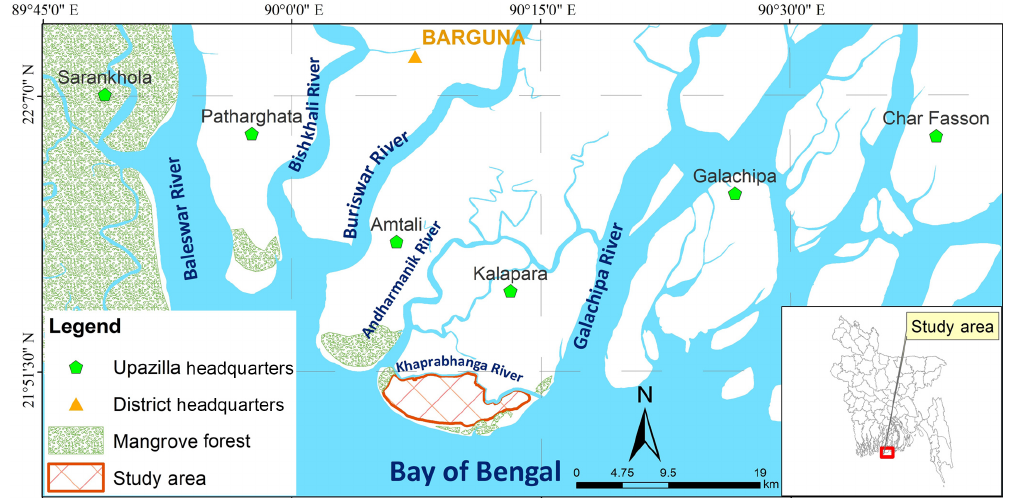
Figure 1. Location map of the study area, Polder 48 (Kuakata).